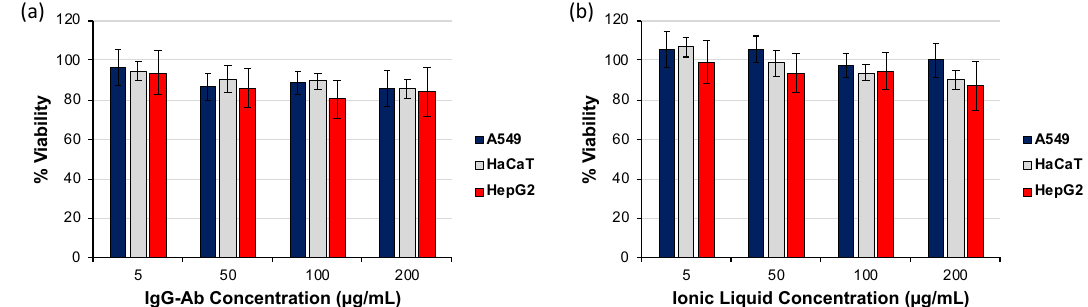
Figure 2. Viability results for A549, HaCaT, and HepG2 cells exposed to ( a ) IgG antibody or the ( b ) unconjugated ionic liquid solution for 24 h. Results were normalized to the no treatment condition for each cell line, and a one-way ANOVA, with a post-hoc Tukey’s analysis was conducted to determine statistical significance. * denotes p-value <